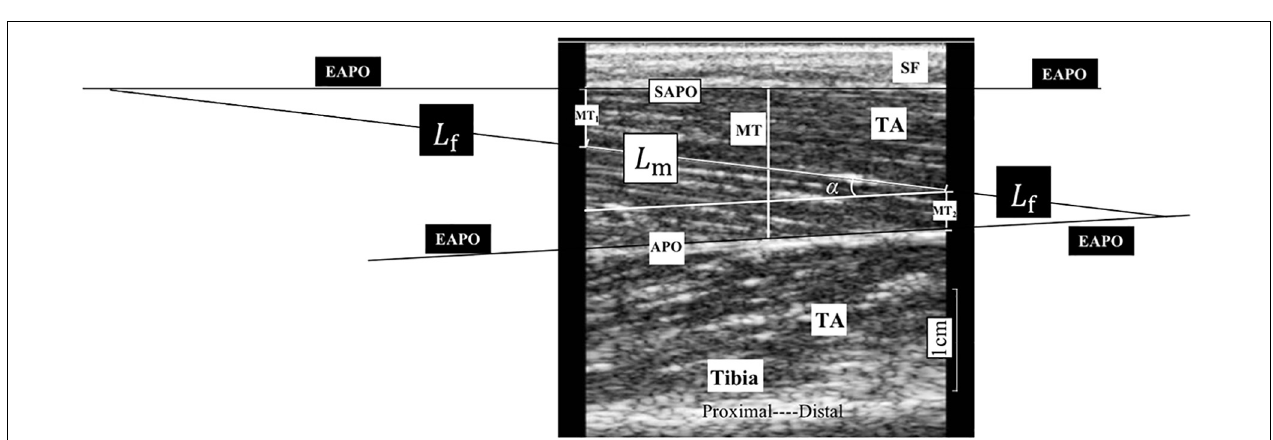
FIGURE 1 | (A) One male subject was relaxed and in supine position on an instrumented bed with foot fixed on the isokinetic dynamometer pedal. One pair of current electrodes (red and black) and one pair of voltage electrodes (yellow and blue) were linearly arranged along the surface of the TA on the muscle belly. An ultrasound probe was placed between voltage current electrodes. (B) Demonstration of positions of EIM parameters and ultrasound probe. I 1 and I 2 were a pair of current electrodes of EIM. V 1 and V 2 were a pair of voltage electrodes of EIM. An ultrasound probe was placed between these two pairs of electrodes. TA, tibialis anterior; EIM, electrical impedance myography.